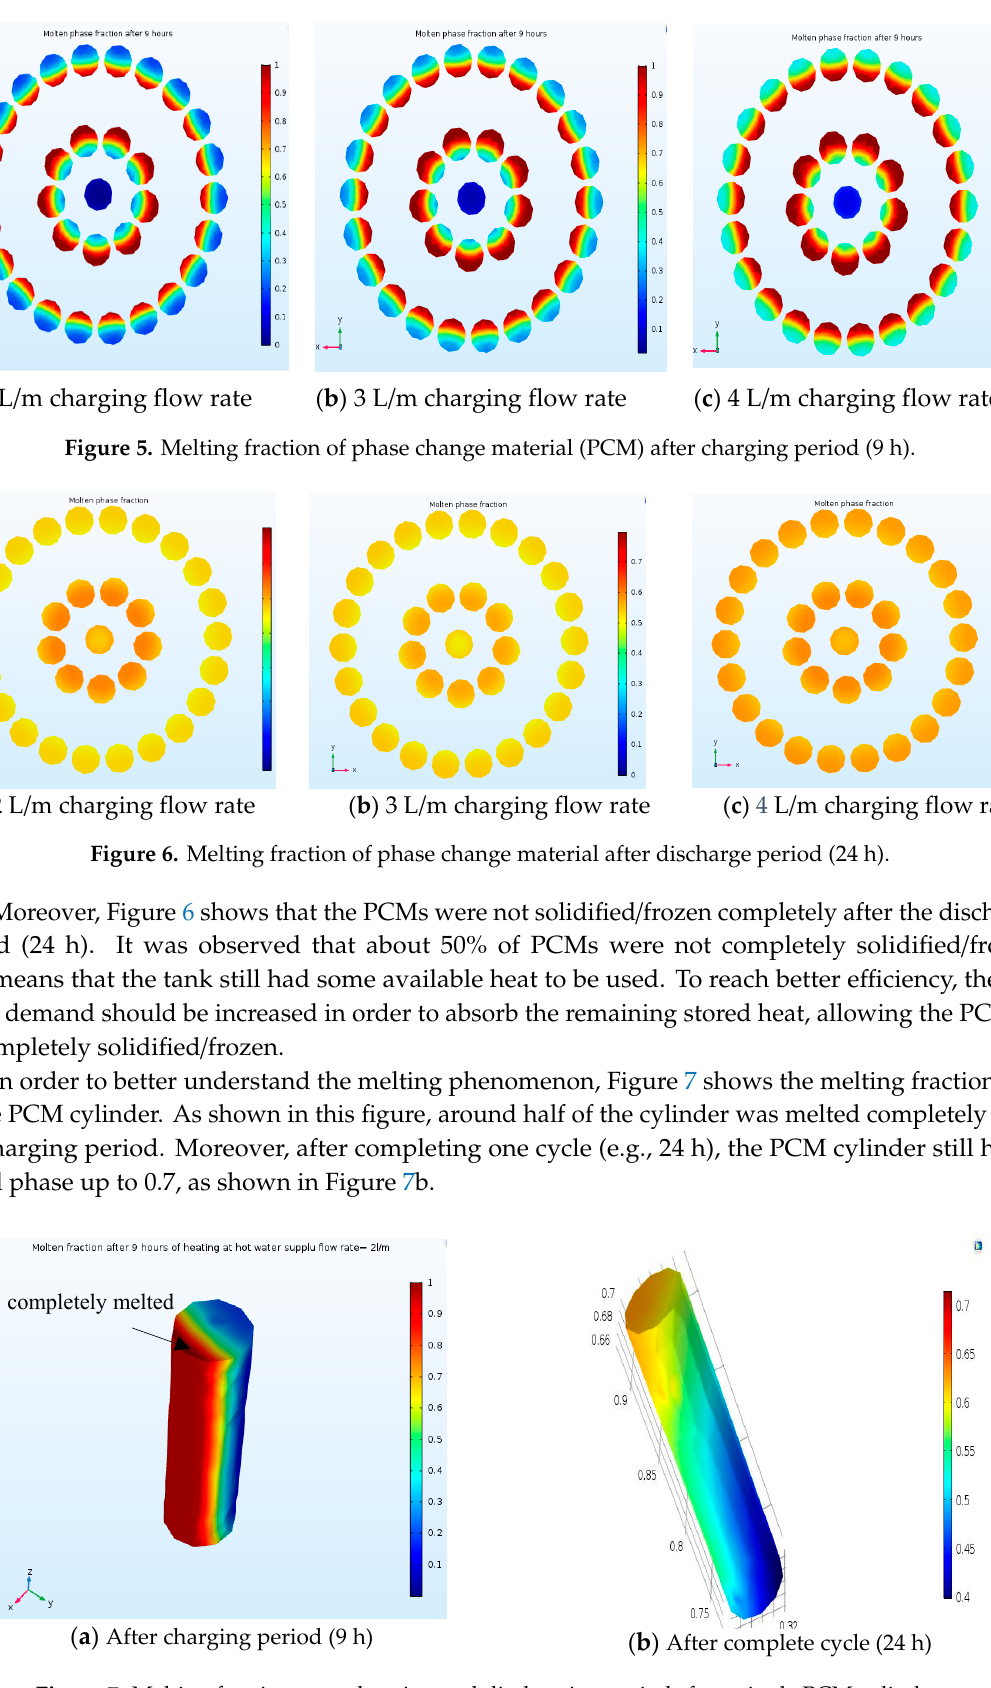
Figure 7. Melting fraction over charging and discharging periods for a single PCM cylinder.